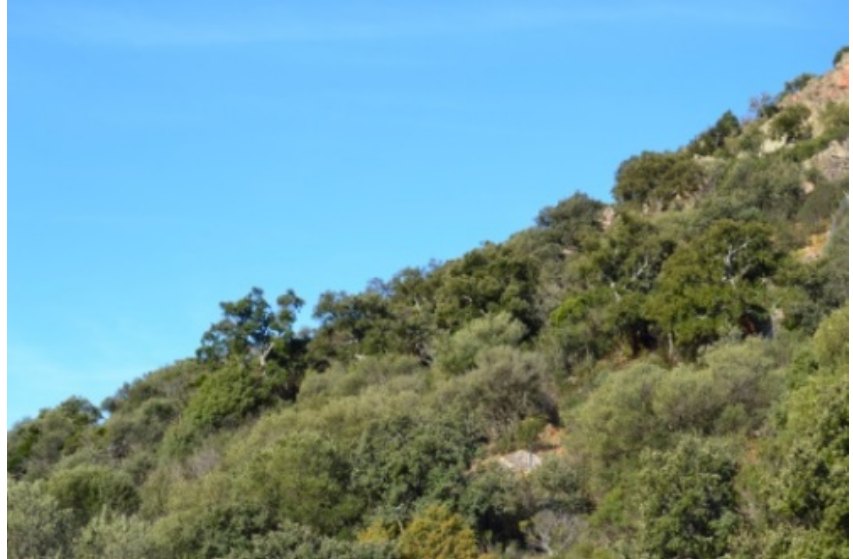
Figure 13. Poterio agrimonioidis – Quercetum suberis .